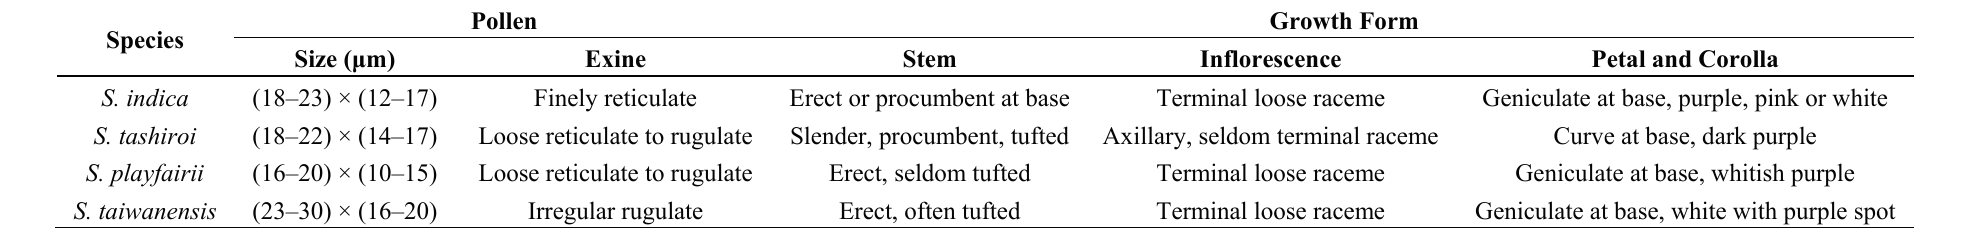
Table 1. Pollen type and growth form of four Taiwanese Scutellaria species used in this study.